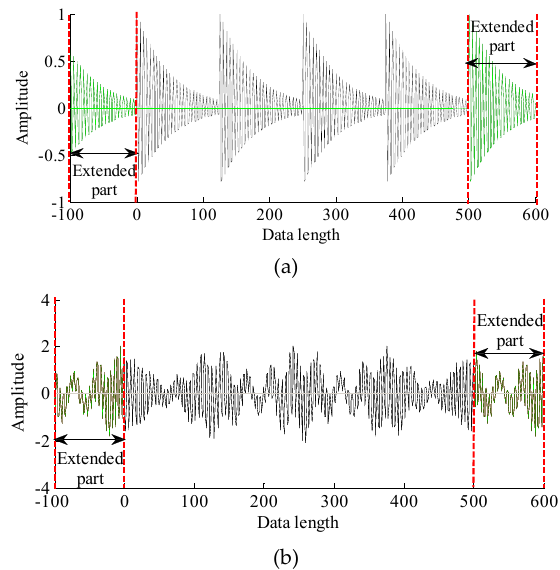
Figure 3. Intuitive examples of the waveform matching extension: ( a ) a cycle shock pulse signal and ( b ) a modulated compound